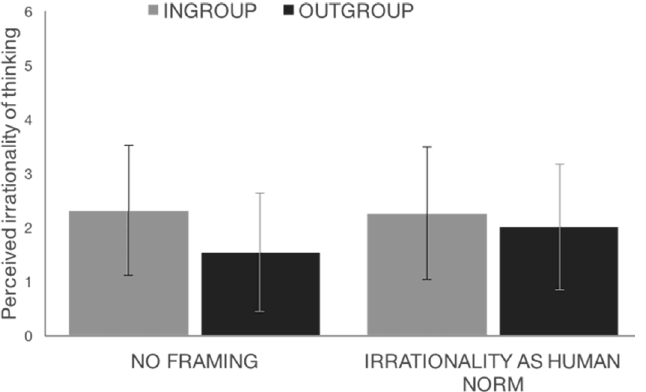
Figure 2. Evaluation of the target person in no framing and irrationality as human trait conditions as a function of the target person’s membership, the Spanish sample in Study 2. Note. Error bars represent standard deviations ( SD